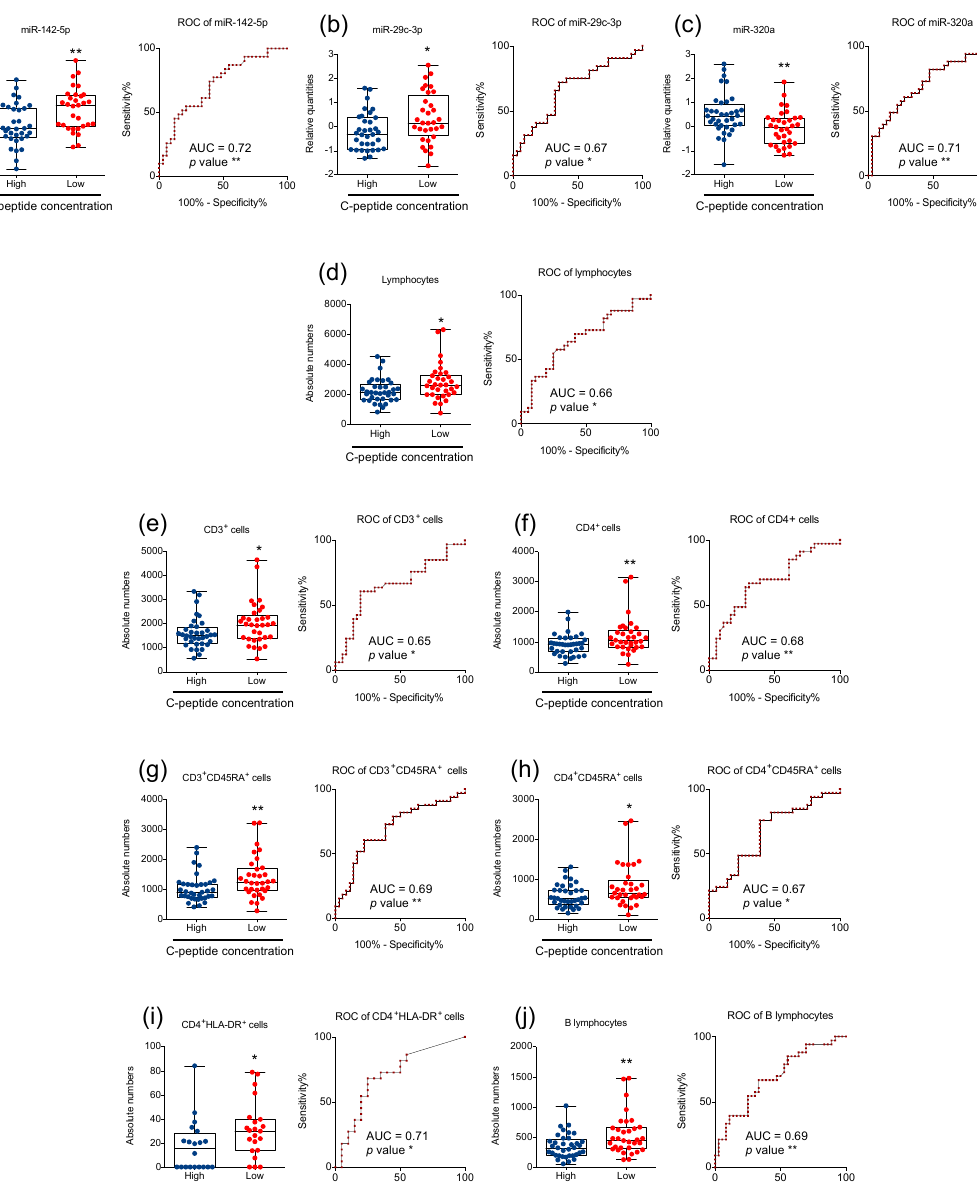
Figure 2. Association of miRNAs and immune cells with residual insulin secretion in T1D children at diagnosis. Whisker plots showing the relative quantities (expressed as log2) of plasmatic miRNAs (a–c) and the absolute number / mm 3 of volume for the indicated peripheral blood circulating immune cells (d–j) in recent onset T1D patients with di ff erent levels of serum C-peptide, as indicated (high ≥ 0.4 ng / ml; low < 0.4 ng / mL). For each parameter, receiver-operating characteristic (ROC) curves showing the capability to discriminate between di ff erent groups of T1D patients, areas under the curve (AUC), and p values are also reported (* p < 0.05, ** p < 0.01). For direct comparisons, Mann-Whitney tests were performed: * p < 0.05, ** p < 0.01. Number of children with high serum C-peptide = 33 and low serum C-peptide = 31 for ( a ); 34 and 32 for ( b ); 36 and 33 for ( c – h , j ); 20 and 22 for ( i ). 2.3. Correlation of Plasmatic miRNAs with Glycemic Control in Children with T1D at Diagnosis Hemoglobin A1c (HbA1c) reflects a 90-day moving average of blood glucose concentrations and its elevated levels have been proposed as an alternative criterion for the diagnosis of diabetes [42]. HbA1c levels in T1D children at diagnosis (whose miRNA levels were analyzed with qPCR